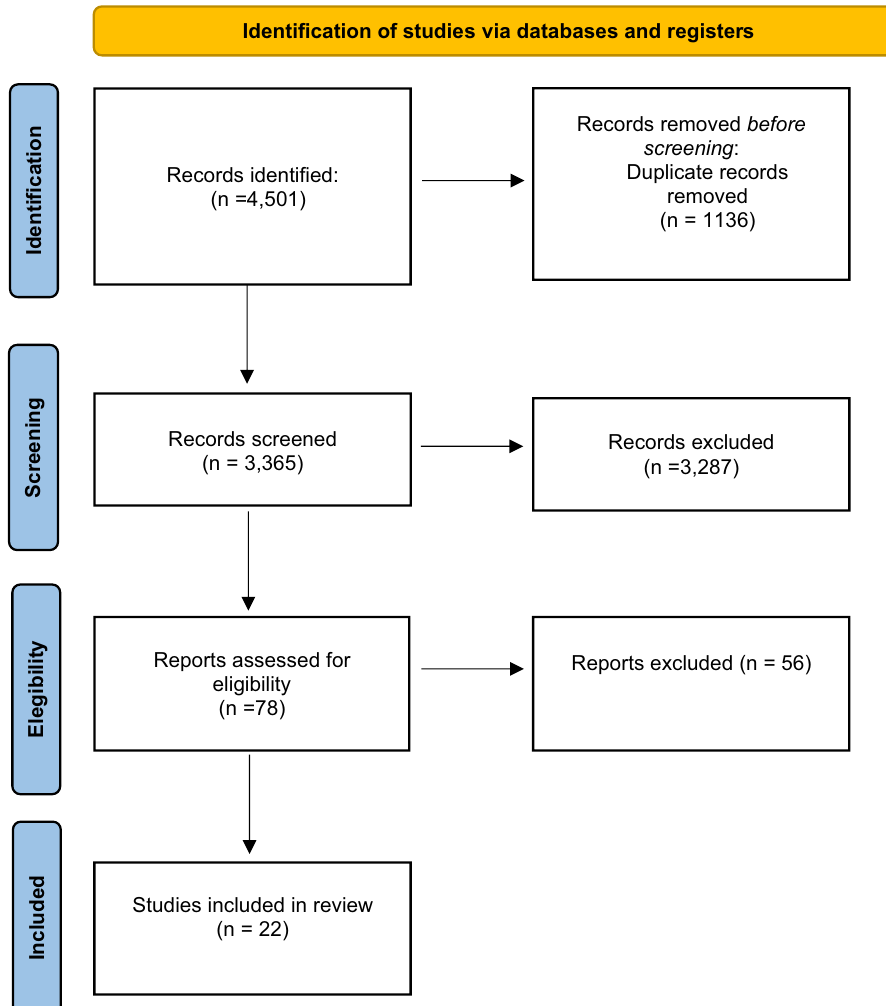
Fig. 1 Flow chart of studies’ selection in the systematic review. Page MJ, McKenzie JE, Bossuyt PM, Boutron I, Hoffmann TC, Mulrow CD, et al. The PRISMA 2020 statement: an updated guideline for reporting systematic reviews. BMJ 2021;372:n71. 10.1136/bmj.n71. For more information, visit: http:// www. prisma- state ment.